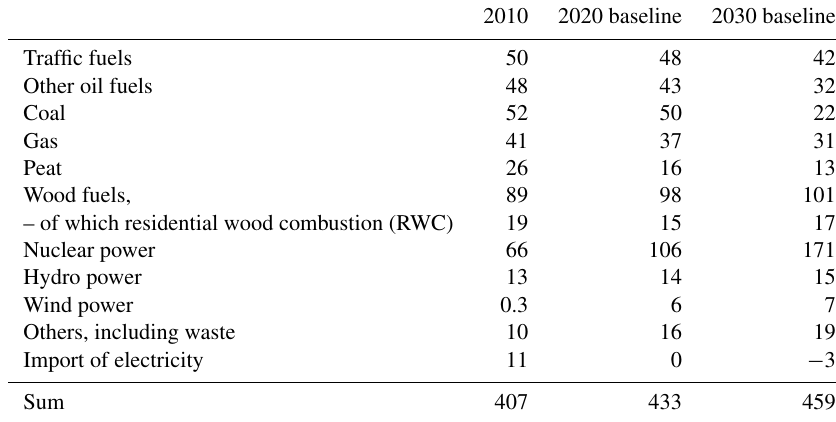
Table 2. Primary energy consumption in Finland (TWha − 1 ) (Ministry of Employment and the Economy,